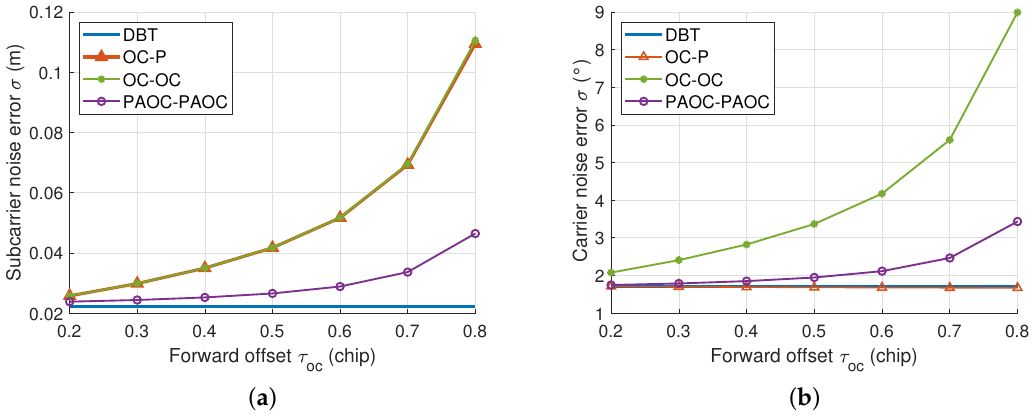
Figure 9. Tracking jitters of various methods for the BOC(15, 2.5) signal without multipath: ( a ) sub- carrier noise error; ( b ) carrier noise